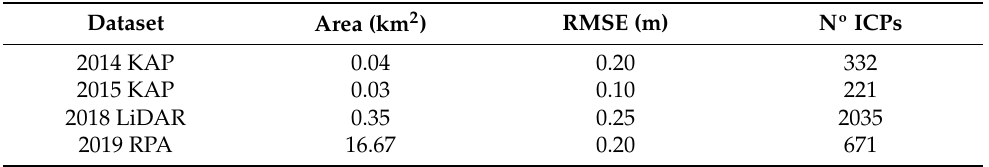
Table 2. Areas, RMS vertical errors of the KAP, LiDAR, and RPA datasets, and the number of ICPs used to assess their vertical